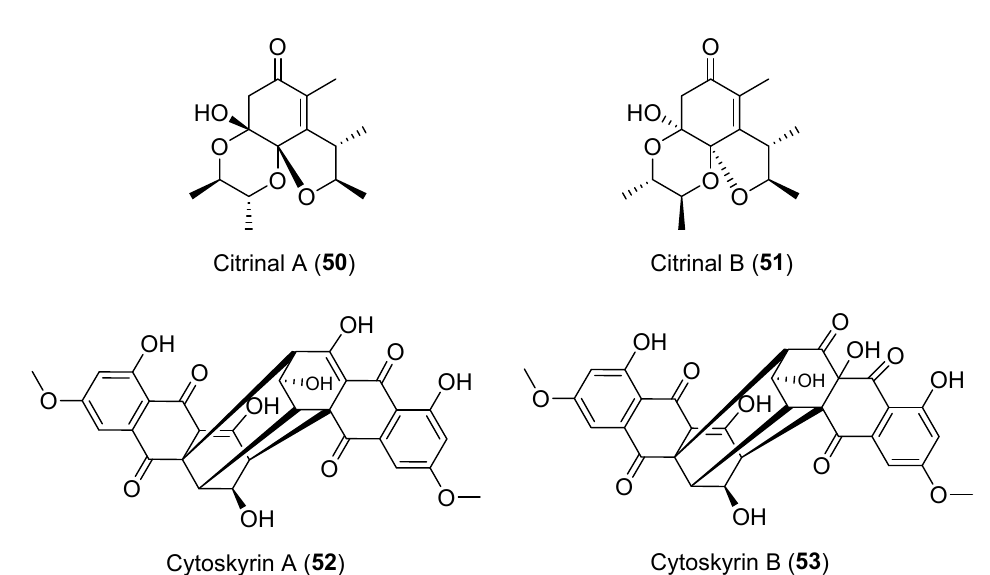
Figure 9. Structures of citrinals A–B ( 50 – 51 ) and cytoskyrins A–B ( 52 – 53 ).